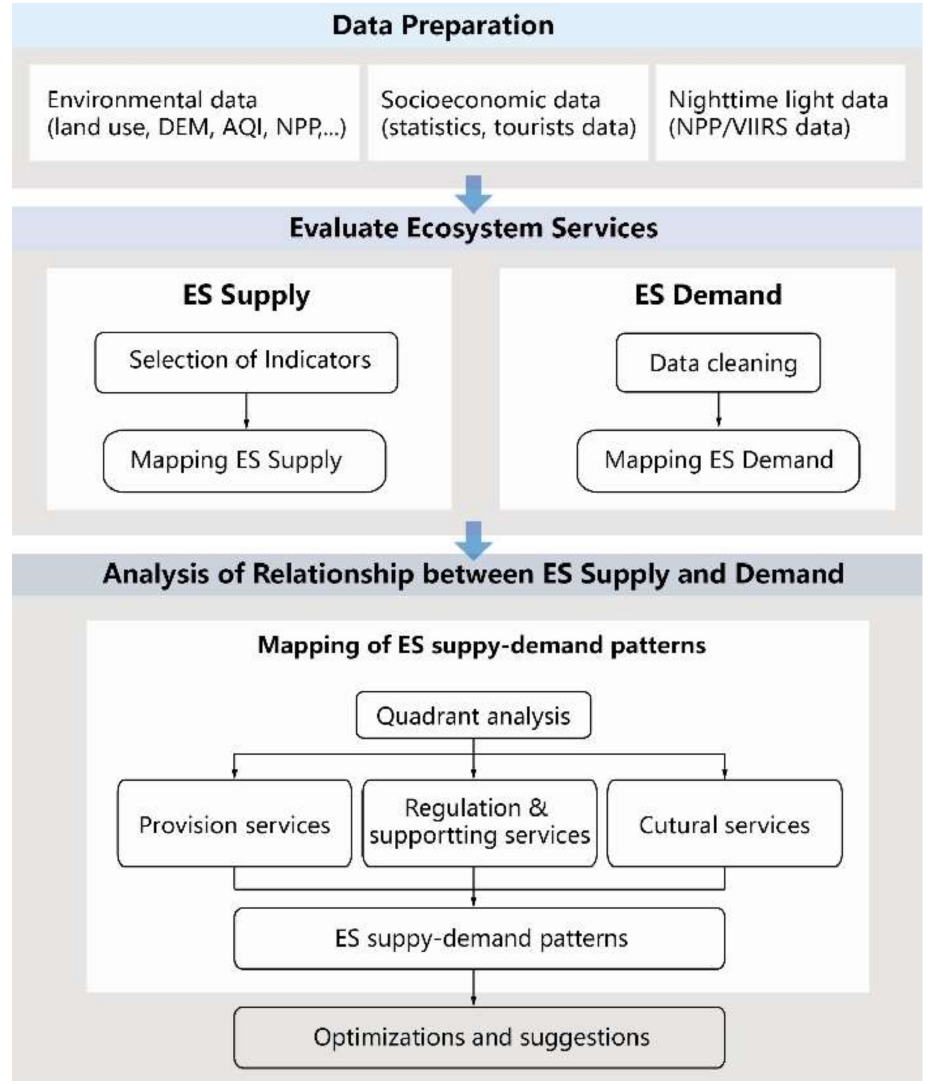
Figure 1. Conceptual